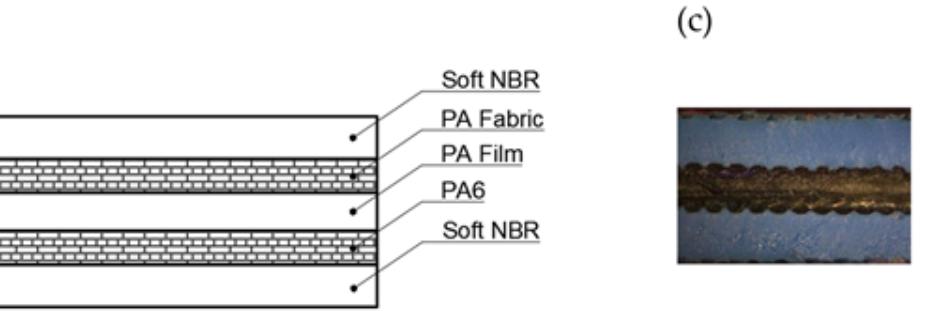
Figure 2. LL2 flat lane ( a ) photography, ( b ) belt cross section, ( c ) optical light microscopy images of the internal structure.